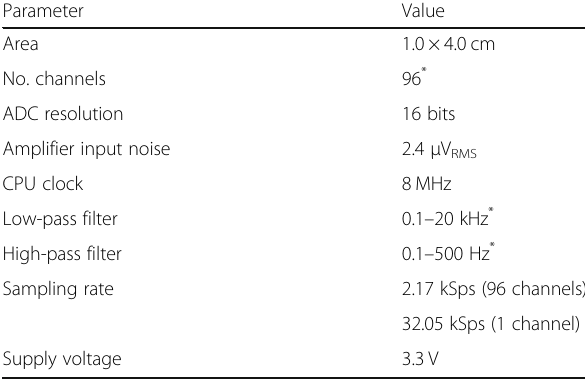
Table 1 Neural Recording Module Design